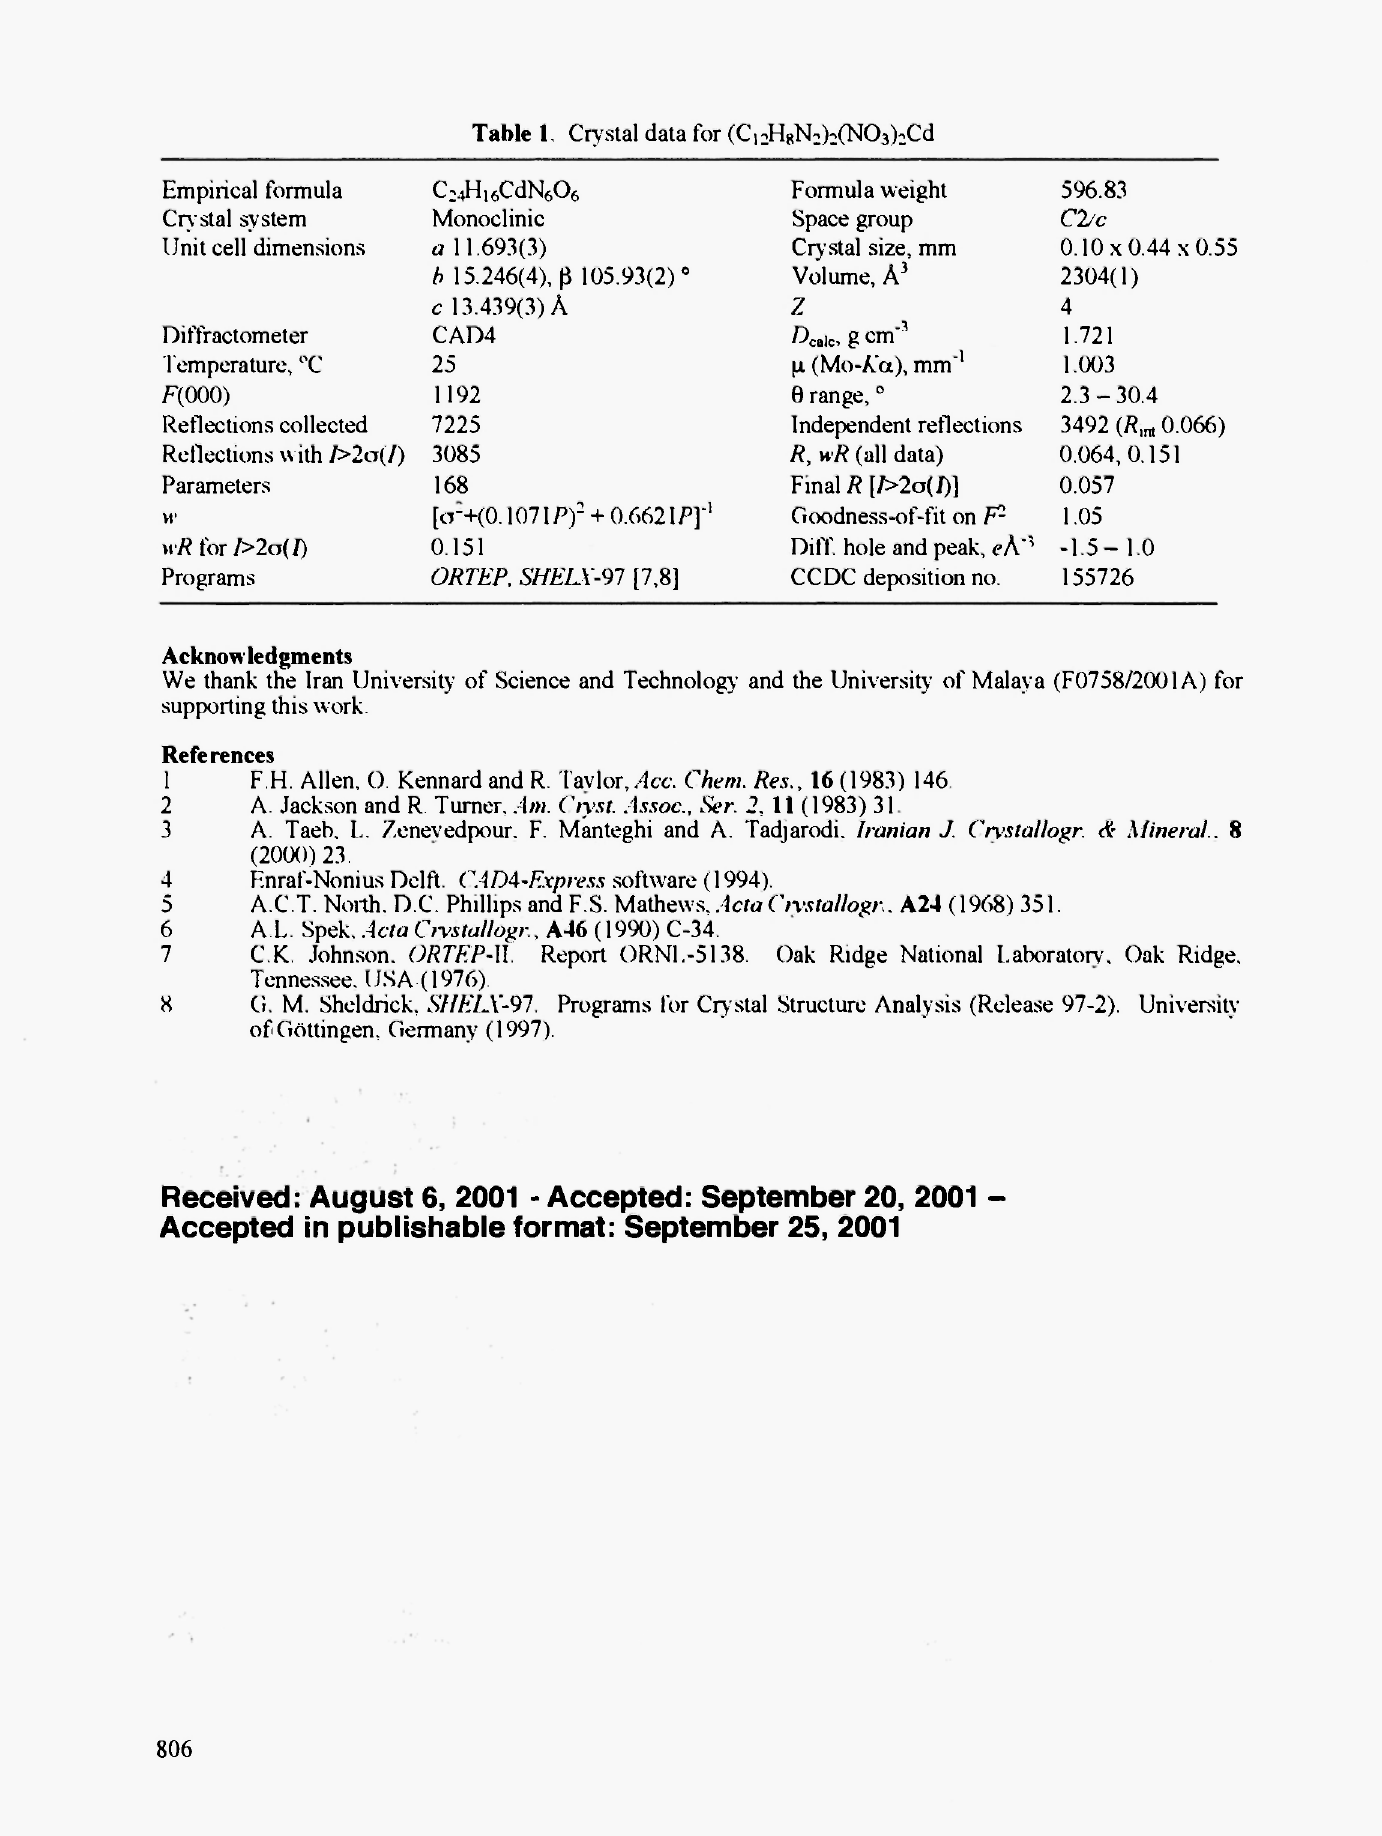
Table 1. Crystal data for (C, 2 H 8 N;) 2 (N0 3 ) :